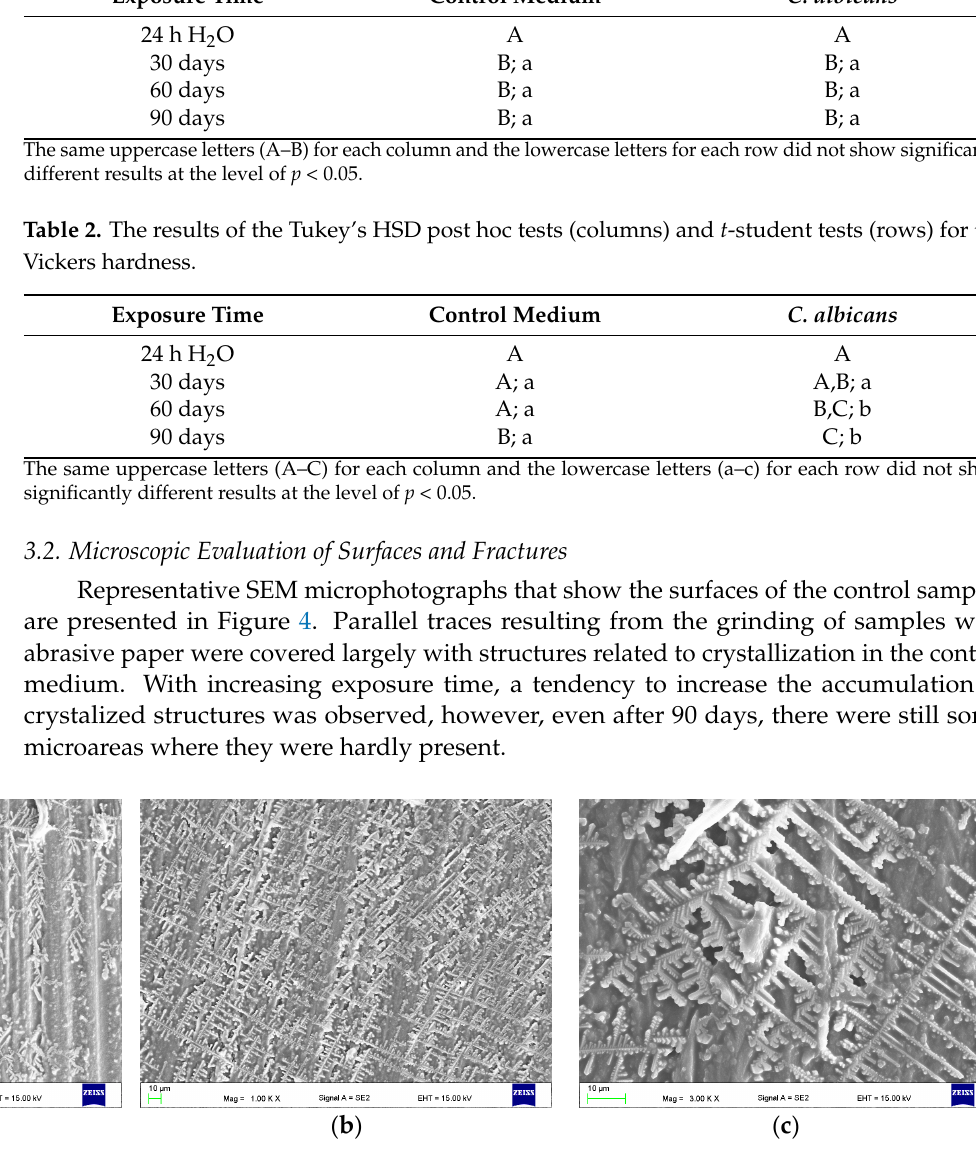
Figure 4. The SEM microphotographs presenting the surface morphologies after 30 days of